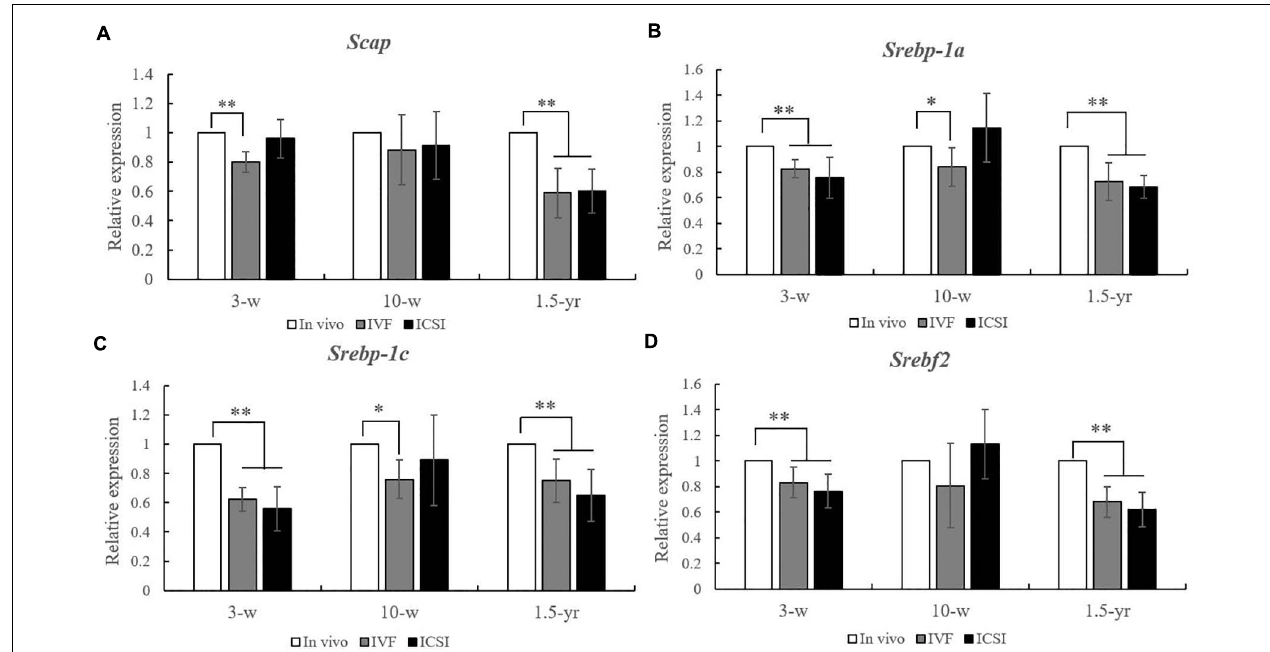
FIGURE 2 | Expression level analysis of Scap , Srebp-1a , Srebp-1c , and Srebf2 mRNA in the lungs from the ICSI, IVF, and in vivo groups ( n = 10/group). mRNA expression level analysis at 3, 10 weeks, and 1.5 years of age by real-time quantitative PCR (RT-qPCR). (A) mRNA expression level of S cap . (B) mRNA expression level of Srebp-1a . (C) mRNA expression level of Srebp-1c . (D) mRNA expression level of of Srebf2. The relative expression levels represent the amount of expression normalized to Gapdh expression. Data concerning the relative amount was calculated by the 2 − (cid:49)(cid:49) Ct method. Mean ± SD values are plotted. Between-group comparisons were made by one-way analysis of variance (ANOVA). * P < 0.05, ** P < 0.01. 3-w, 3 weeks; 10-w, 10 weeks; 1.5-yr, 1.5 years